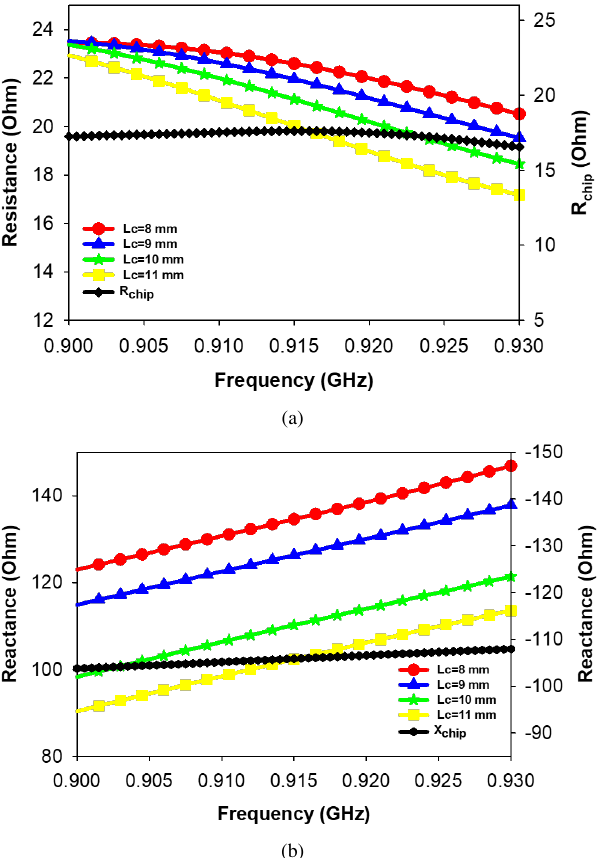
FIGURE 3: Simulated input impedance of the proposed RFID tag antenna for different length LC of the tuning patch at the North American band.